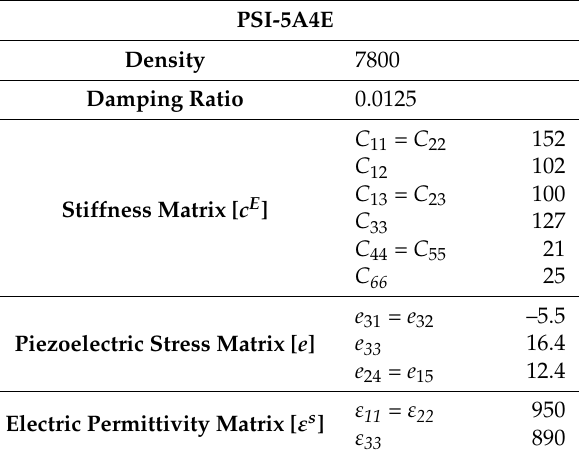
Table 4. Properties of the PZT for ANSYS simulation.